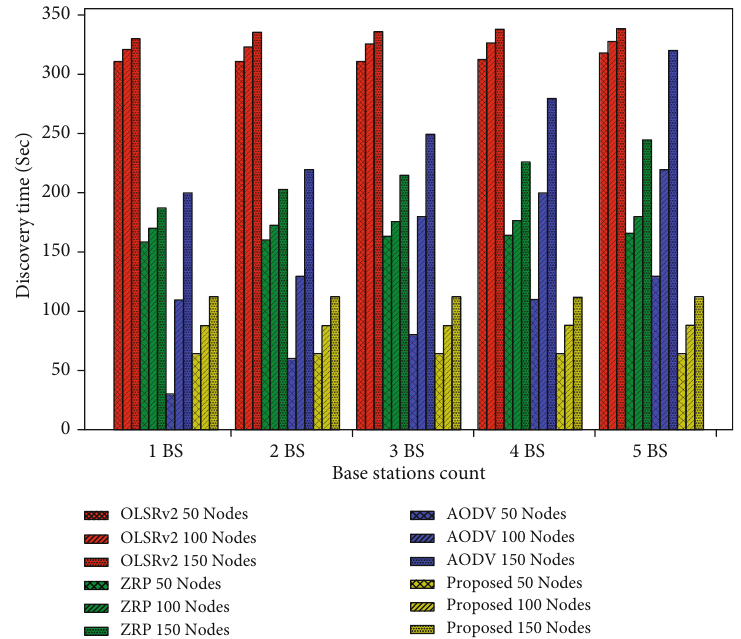
Figure 12: In fl uence of the number of base stations and mobile nodes on the route discovery